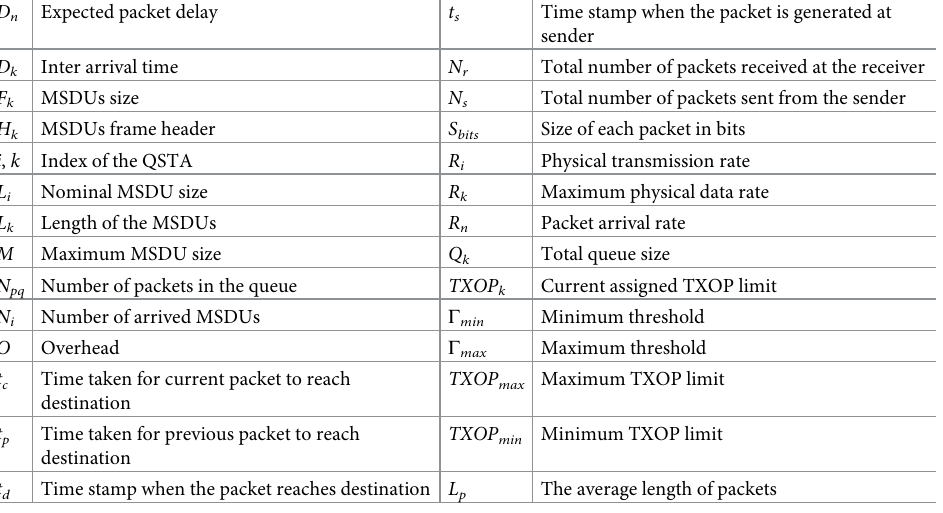
Table 1. The mathematical notations of the EDTXOP